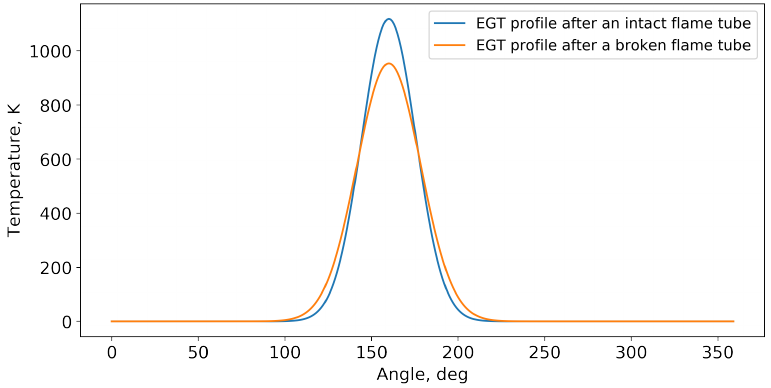
Figure 5. Exhaust gas temperature distribution after one flame